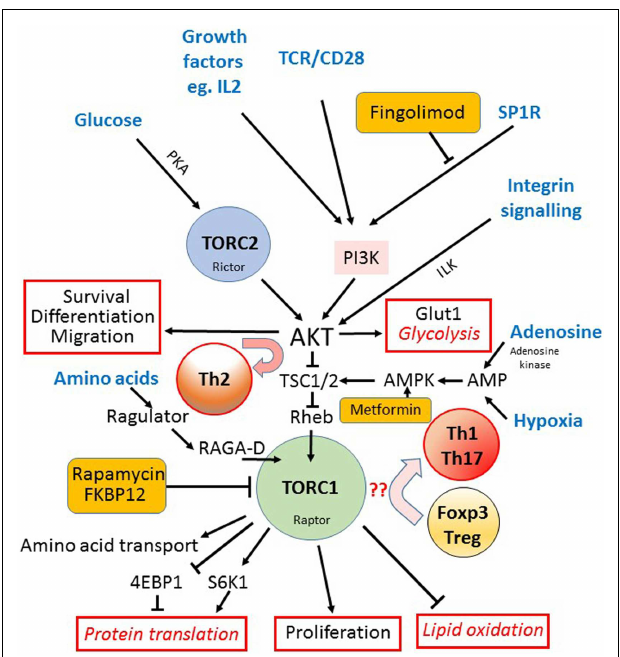
FIGURE 2 |The mTOR pathway inT cells .The mechanistic target of rapamycin (mTOR) is a component of both theTORC1 andTORC2 signaling complexes.TheTORC1 complex acts as the main integrator of many different signals (input signals shown in blue text) from nutrients such as glucose, viaTORC2, theTCR, costimulation and growth factors, via PI3K and AKT, and amino acids via the regulator complex. Hypoxia and AMP levels are also sensed via AMPK andTSC1/2. AKT activation downstream of TORC2 is important for cell survival, drives the expression of the glucose receptor (Glut1) and glycolytic metabolism, and is required for the differentiation intoTh2 cells (outputs of signaling shown outlined in red). TORC1 is important for the initiation of mRNA translation via S6K1 mediated phosphorylation of the ribosomal protein S6, and the up-regulation of amino acid transporters at the cell surface.TORC1 also activates lipid oxidation and cell proliferation while it inhibits the expression of FOXP3 andTreg differentiation in favor ofTh1 andTh17 cells.The sites where three different clinically available drugs (rapamycin, fingolimod, and metformin) impact on the mTOR pathway are indicated (orange